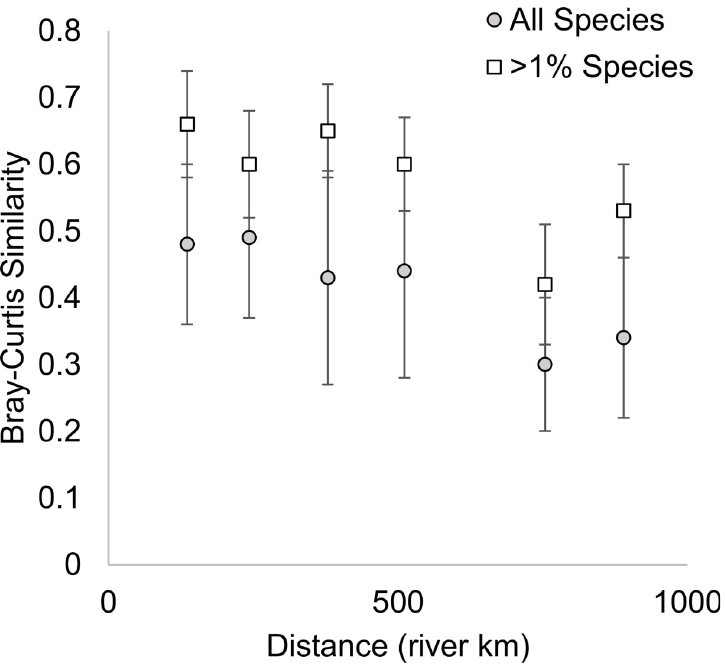
Fig 3. Average similarity (with standard deviation) over the 21 years for which data are available between fish communities of pools of the upper Mississippi River (Pools 4, 8, 13 and 26). regression relating β | to year had an AIC that was ~3 units lower than a comparable DIST YEAR C null model and the standardized slope was negative ( b = -0.48 [-0.89,-0.07], R 2 = 0.16), suggest-